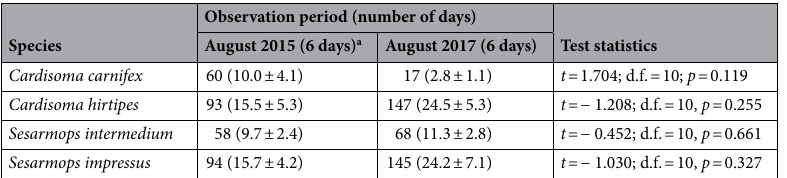
Table 1. Total number of ovigerous females and mean number of ovigerous females recorded per day (in parentheses) for several dominant land crab species recorded during the breeding season in Houwan (2015, 2017). a Data were obtained from Liu 38 .